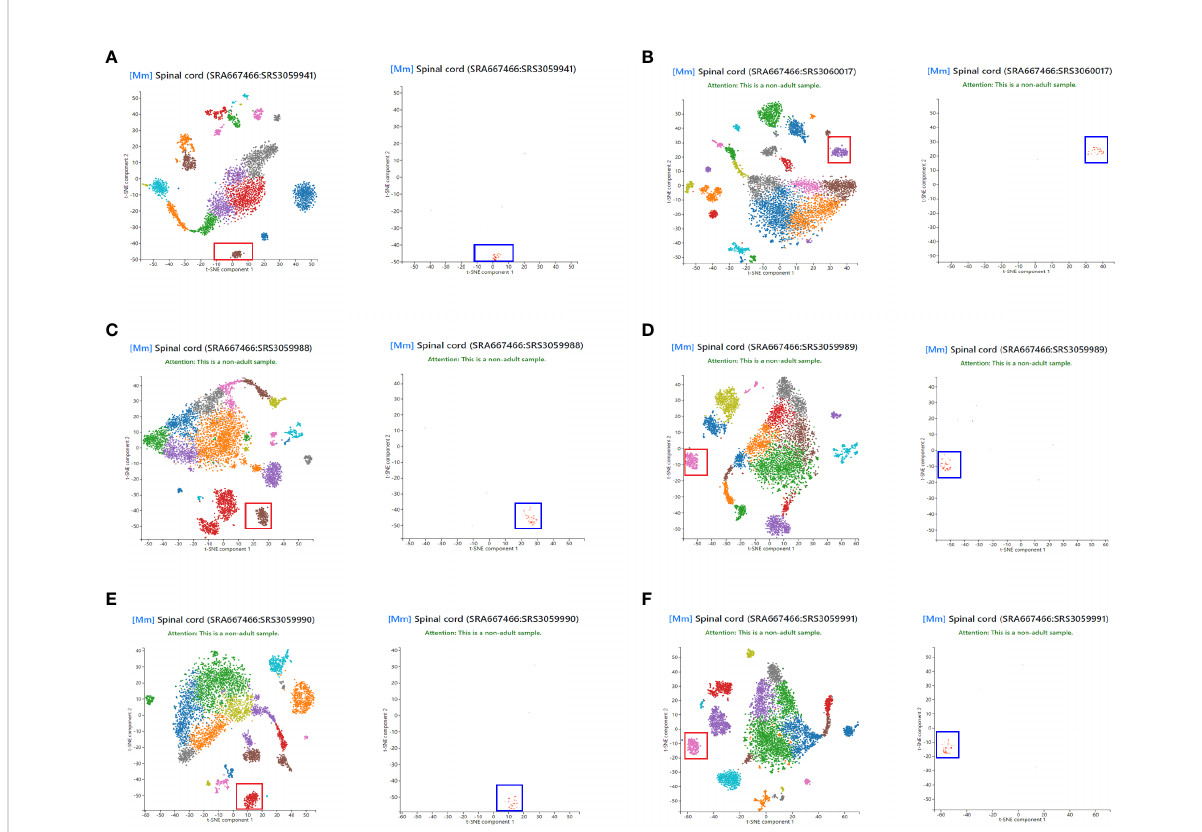
FIGURE 2 NLRP3 is exclusively expressed in disc microglia. Single cell expression pro fi le for mouse spinal cord was obtained from Panglaodb. (A – F) In all analyzed 6 mouse spinal cord samples, NLRP3 (blue rectangle) was exclusively expressed in disc microglia clusters (red